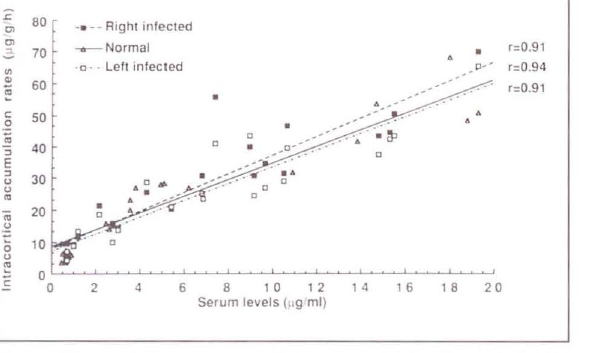
Figure 1) Intrarenal accumulation kinetics of gentamicin in normal and Enterococcus faecalis-irifected kidneys.